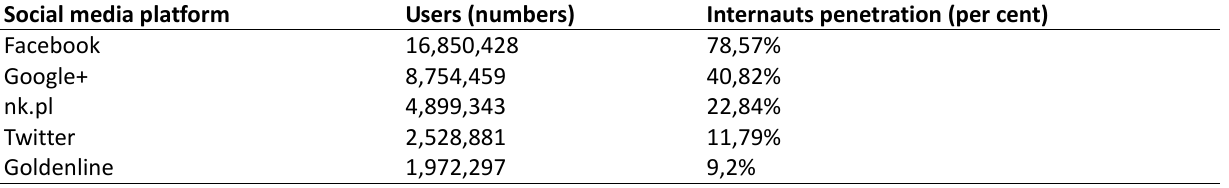
Table 1. Social media market in